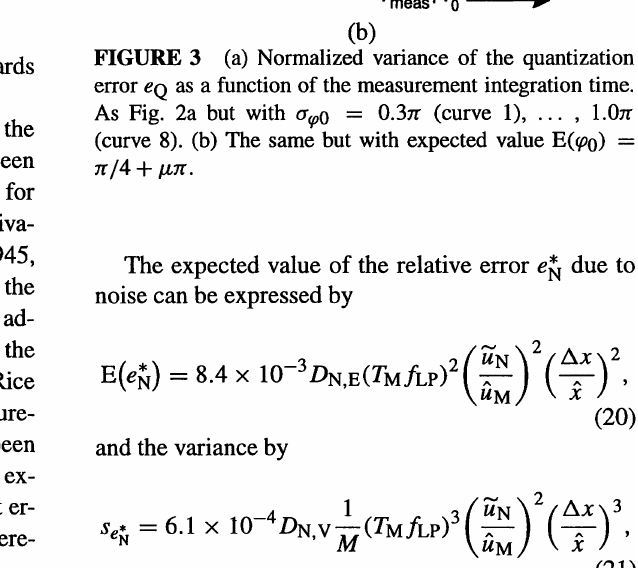
FIGURE 2 (a) Normalized autocorrelation function of the quantization error eQ. As Fig. la but with vb.x/4; v = 0,1,2, ... , (jqJo = 0.2n (curve 1), 0.3n (curve 2), ... , 0.6n (curve 5). (b) The same but with ex pected valueE(cpo) = n/4+ fJ-n; curve 6: O:qJo = 0.7n.